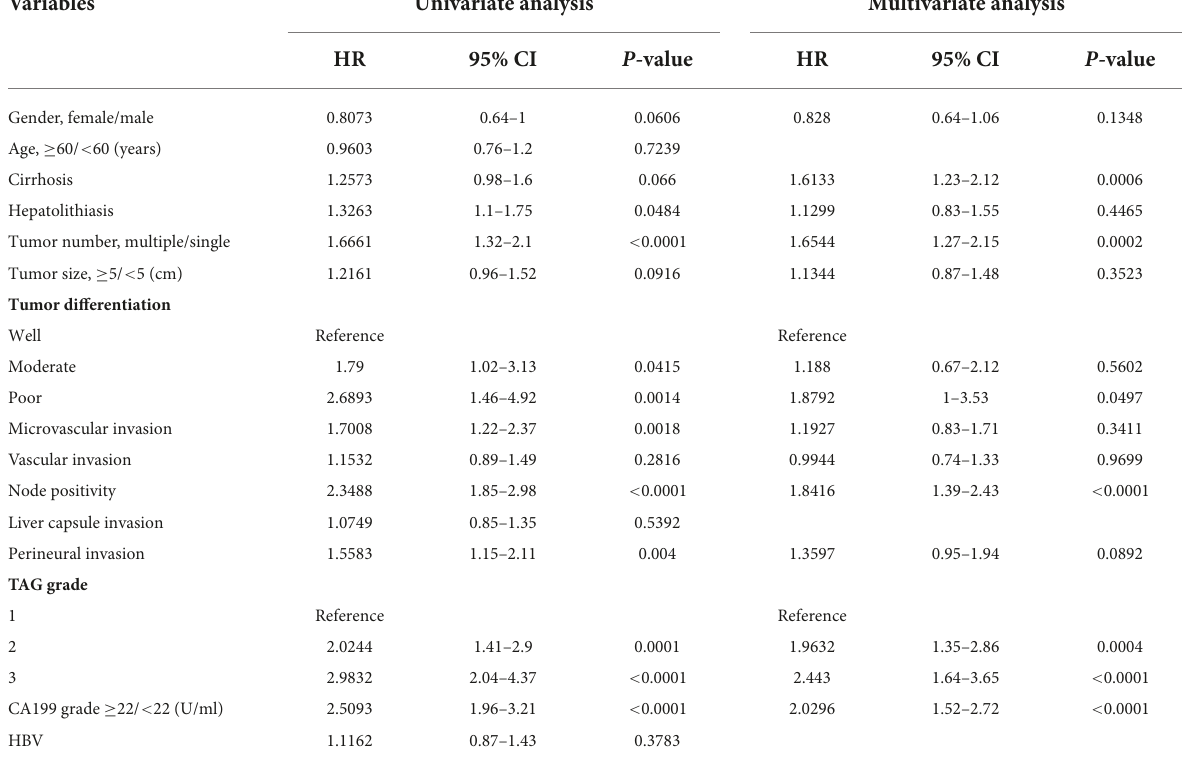
TABLE 4 Univariate and multivariate analyses to determine independent predictors of overall survival in the discovery set.